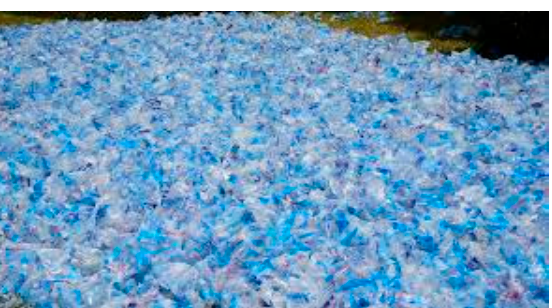
Figure 1. Collected cut water sachets, manually washed and dried. Source: Trashy Bags [39].